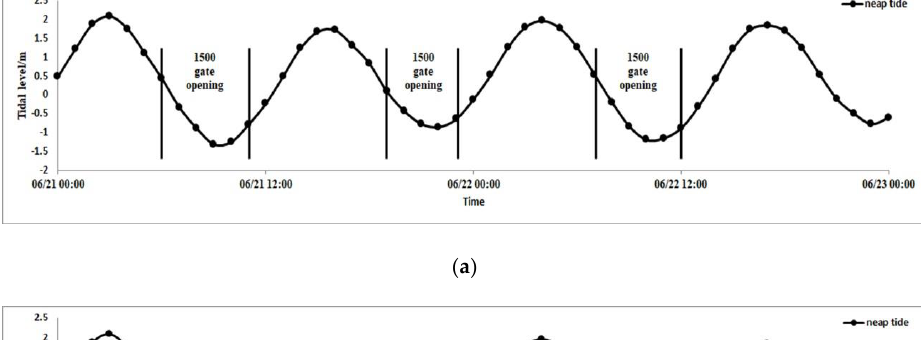
Figure 6. Dispatch diagram of gate control boundary discharging with flow of ( a ) 1500 m 3 /s, ( b ) 3000 m 3 /s and ( c ) 5000 m 3 /s, respectively during spring tide.